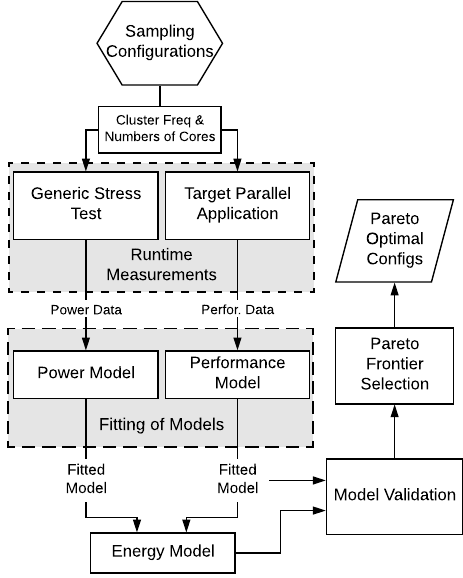
Figure 1. Flowchart of the methodology applied for predicting the optimal performance and energy efficiency trade-offs of a parallel